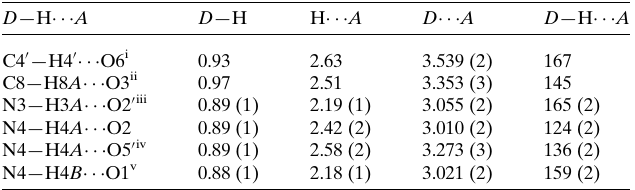
Table 1 Hydrogen-bond geometry (A˚ , (cid:4) ).